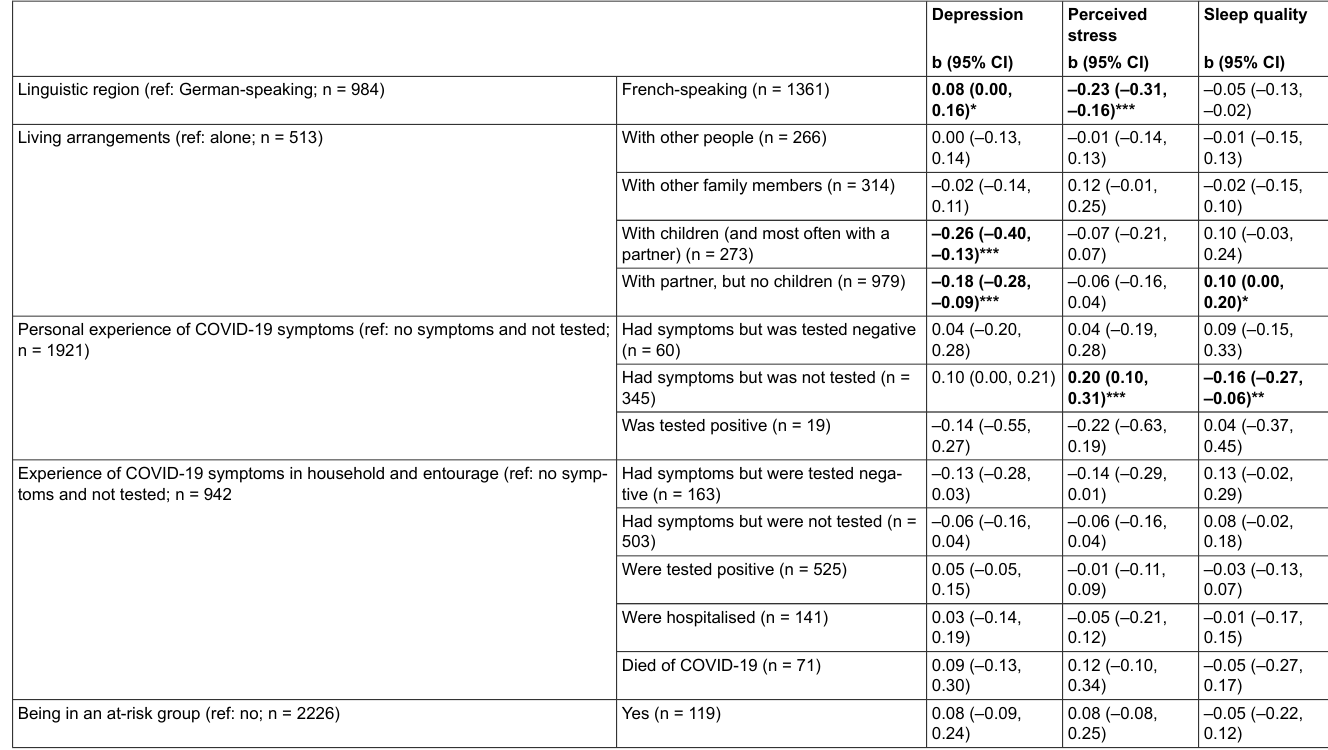
Table 4: Associations of the psychological consequences of the COVID-19 crisis with mention of it as a cause, measured during COVID-19 and adjusted for pre-COVID-19 levels, with linguistic region, living arrangements, experiencing COVID-19 symptoms and being in an at-risk group